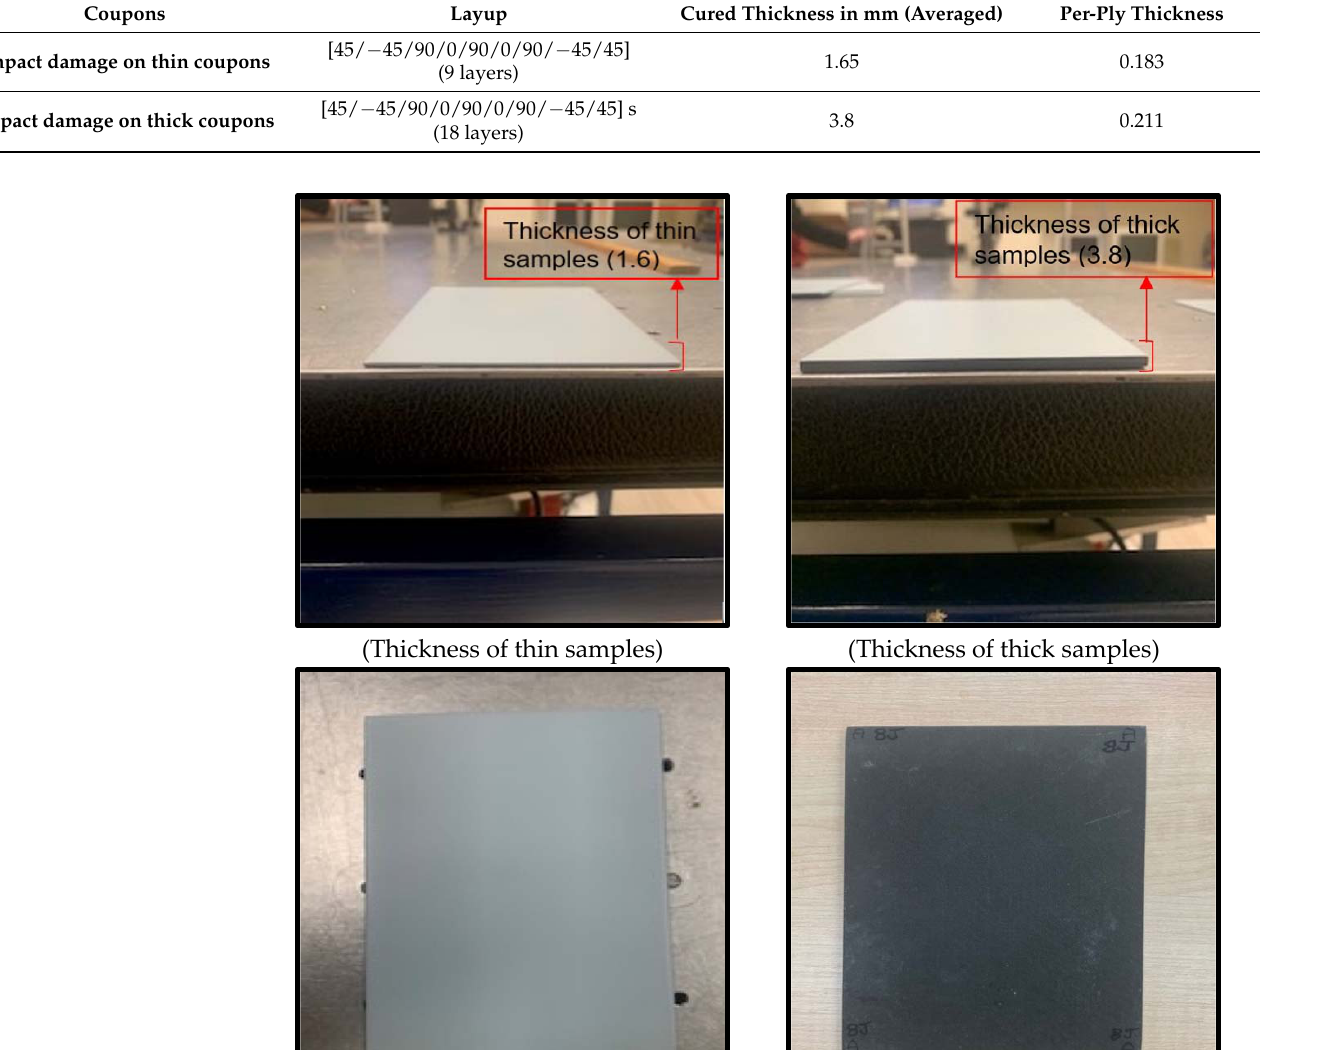
Table 3. Infrared camera specifications.